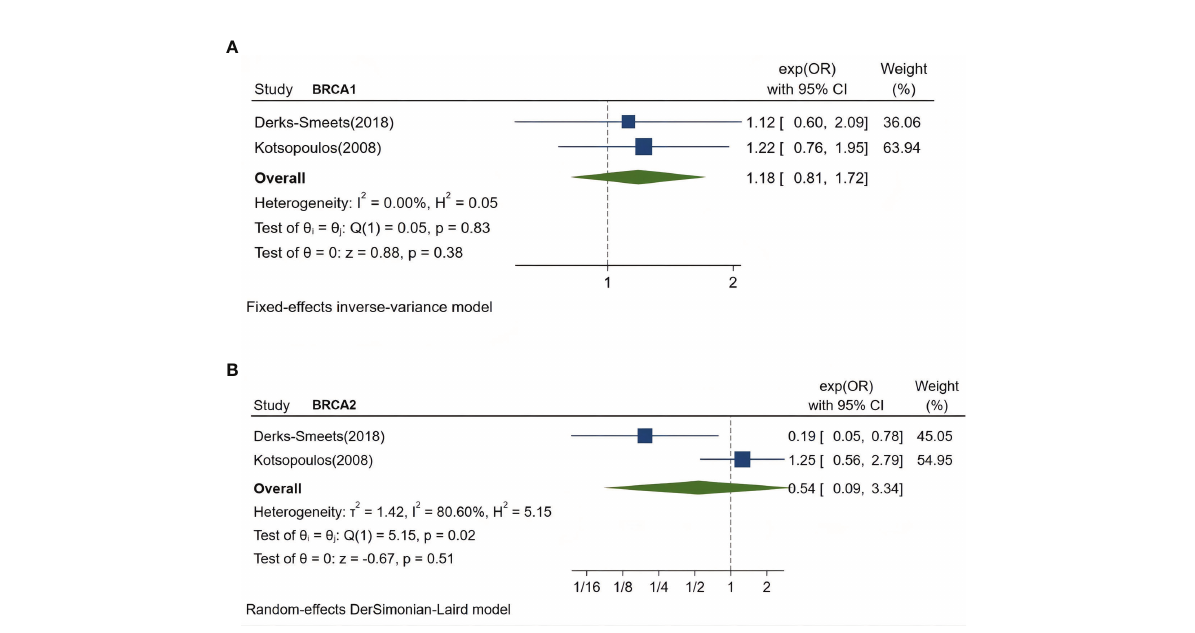
FIGURE 3 Forest plots demonstrating the comparison of breast cancer risk in women with BRCA1 mutations or BRCA2 mutations who were treated by fertility treatments or not. (A) , comparison of breast cancer risk in women with BRCA1 mutations. (B) , comparison of breast cancer risk in women with BRCA2 mutations. OR, odds